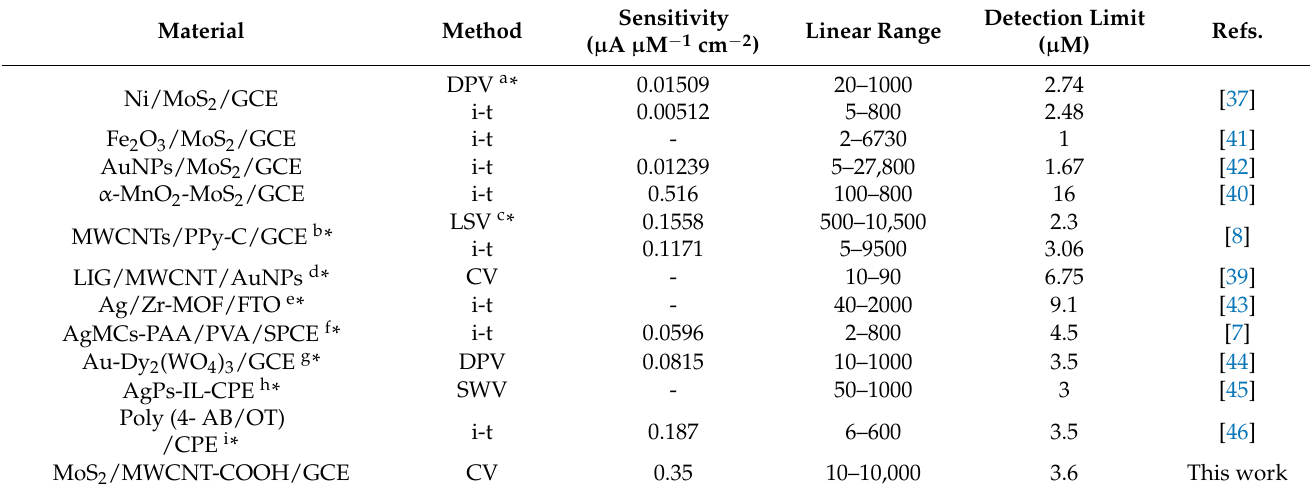
Table 1. The comparisons of different modified electrodes on nitrite